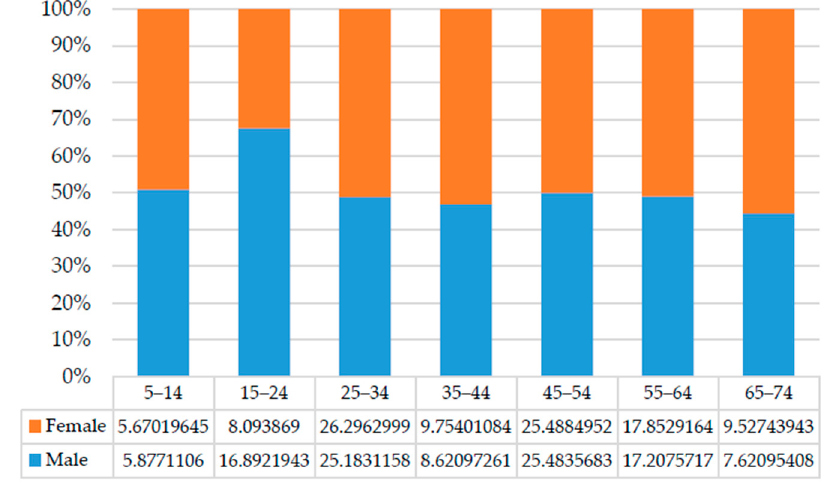
Figure 4. Distribution of age and gender.